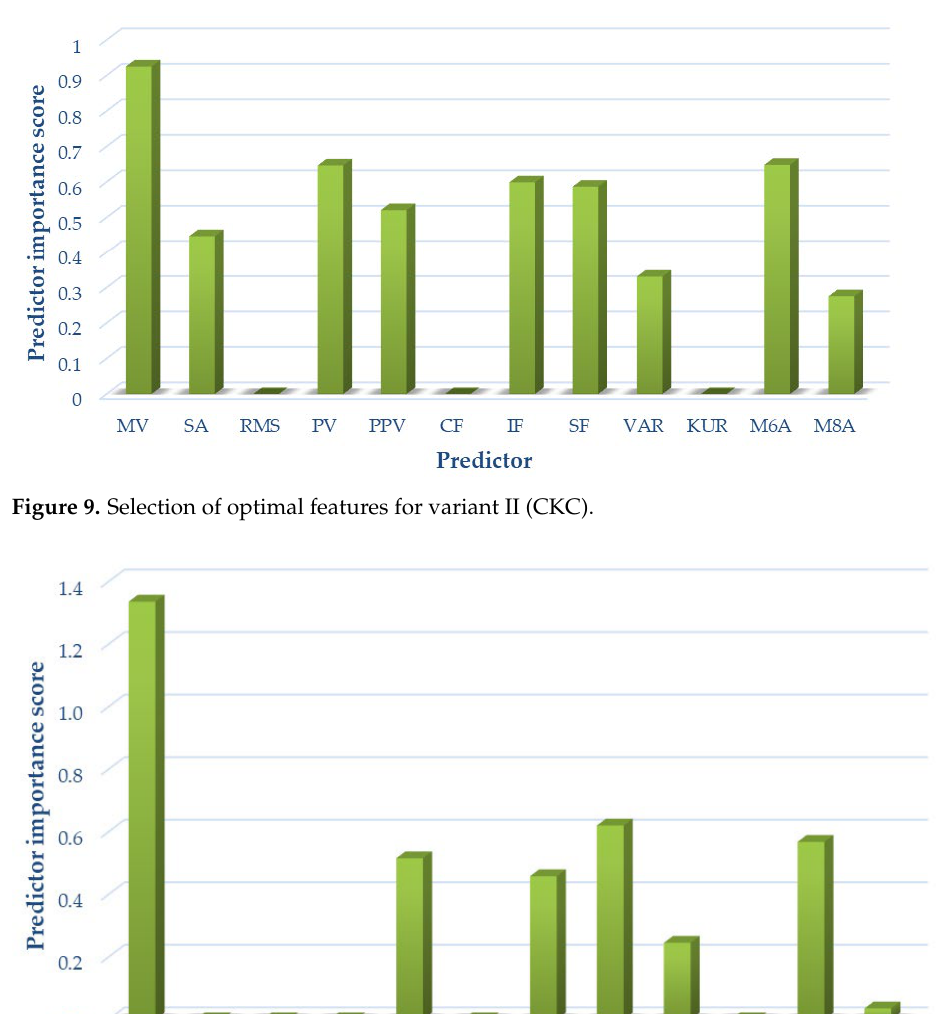
Figure 8. Selection of optimal features for variant I (OKC) .